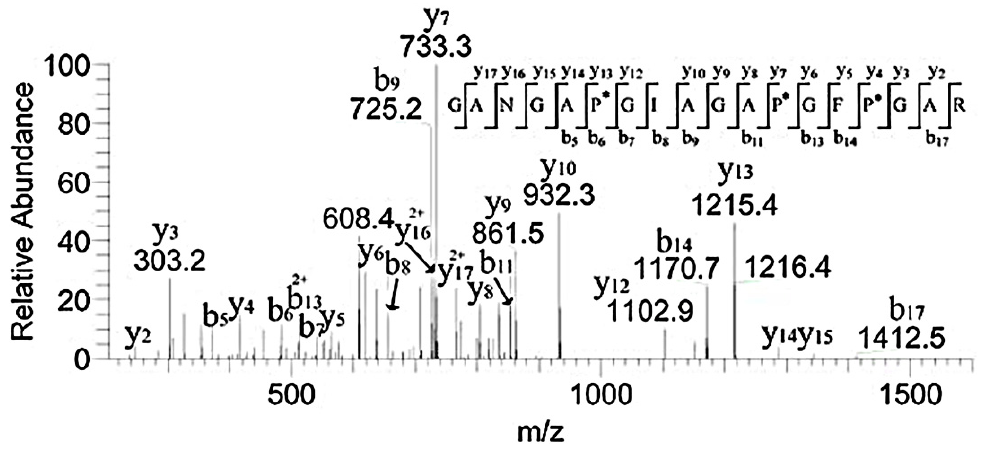
Figure 7. MS/MS spectrum of m / z 793.6 corresponding to the sequence GAN- GAP*GIAGAP*GFP*GAR. “*” indicated the hydroxylation modification of the proline.